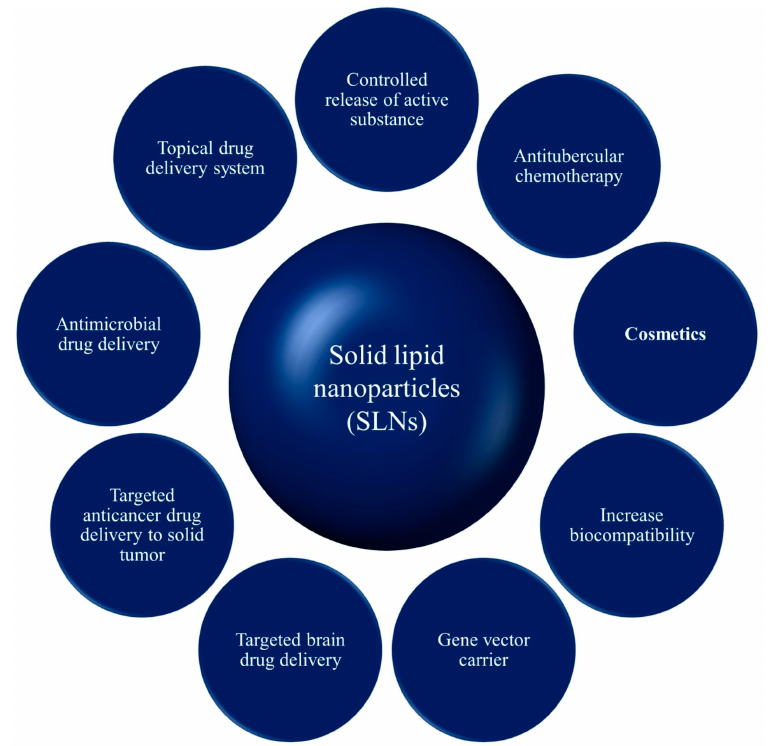
Figure 7. Schematic representation of applications of SLNs.